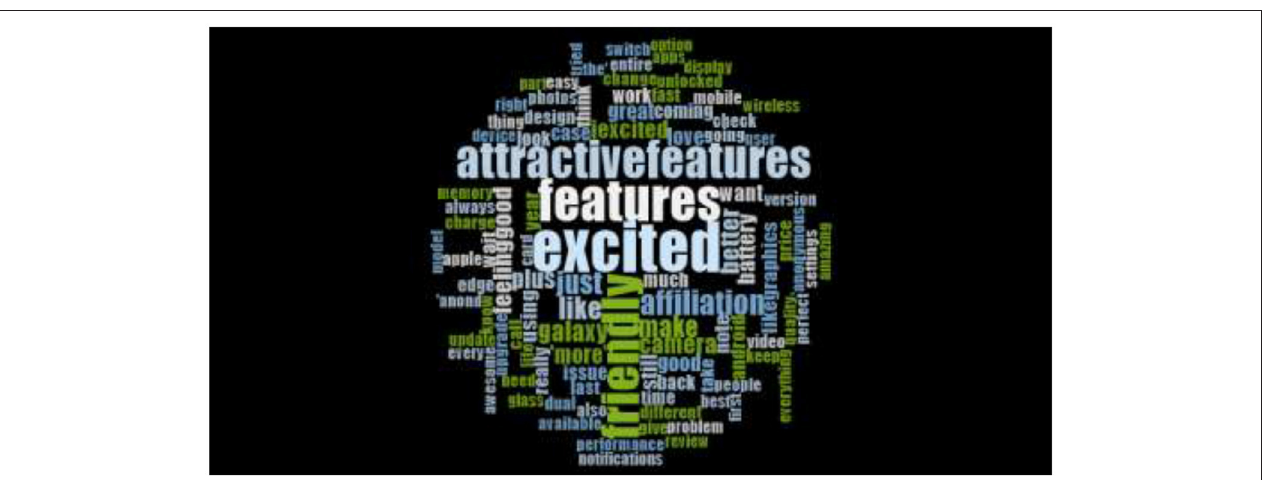
FIGURE 2 | Across the globe Consumer’s Tweets word cloud for Samsung Galaxy